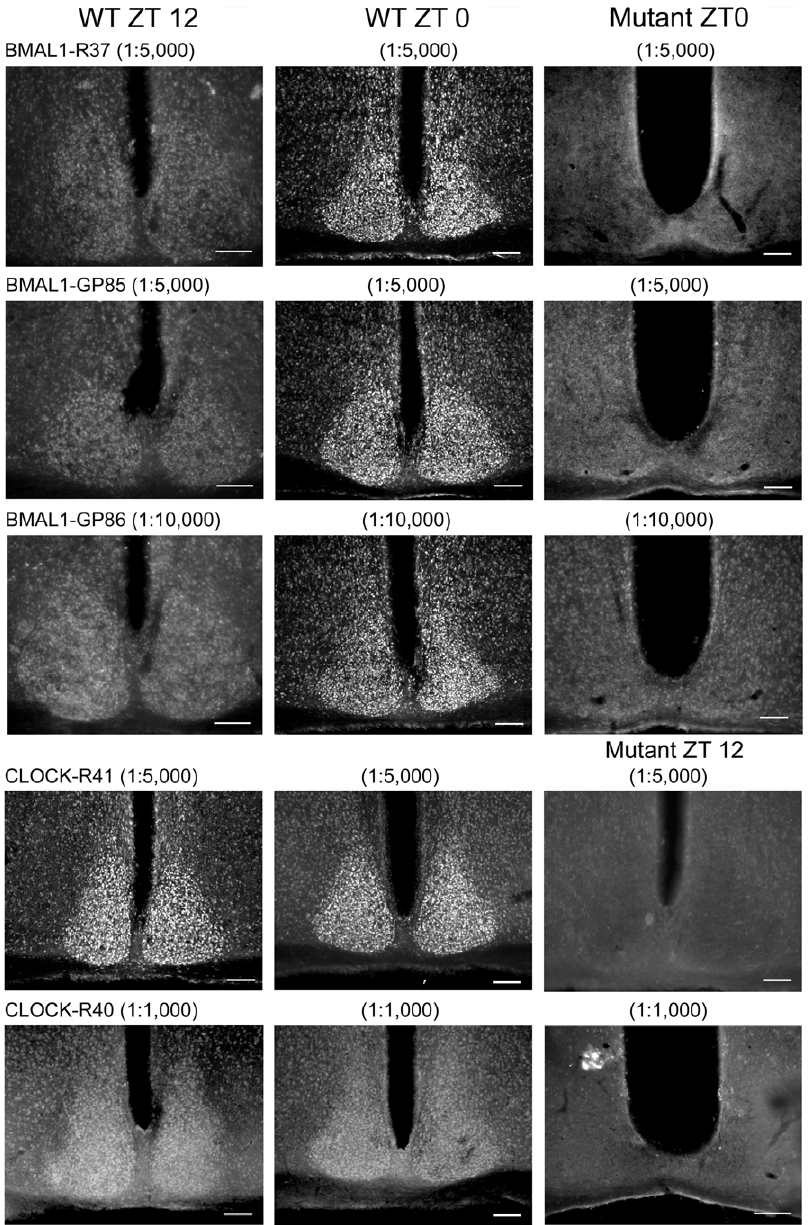
Figure 2. Photomicrographs of mouse SCN sections immunostained with BMAL1 and CLOCK antibodies. The left column shows sections from wild-type mice euthanized at ZT12. The center column shows sections from wild-type mice euthanized at ZT0. The right column shows sections from mice lacking the target antigen (‘‘mutant’’) at ZT0 or 12, as indicated. The antigen, host number (R=rabbit; GP=guinea pig) and antibody concentration used for each antibody is indicated. Scale bar, 100 m m.